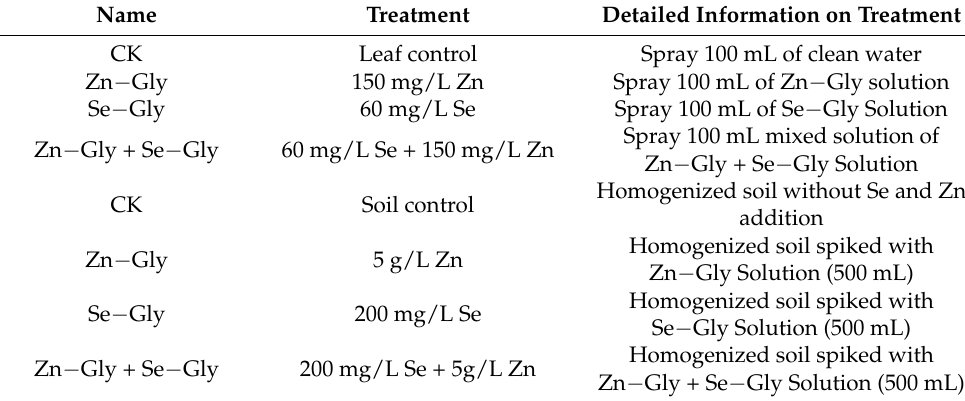
Table 7. Treatment design of Zn − Gly and Se − Gly